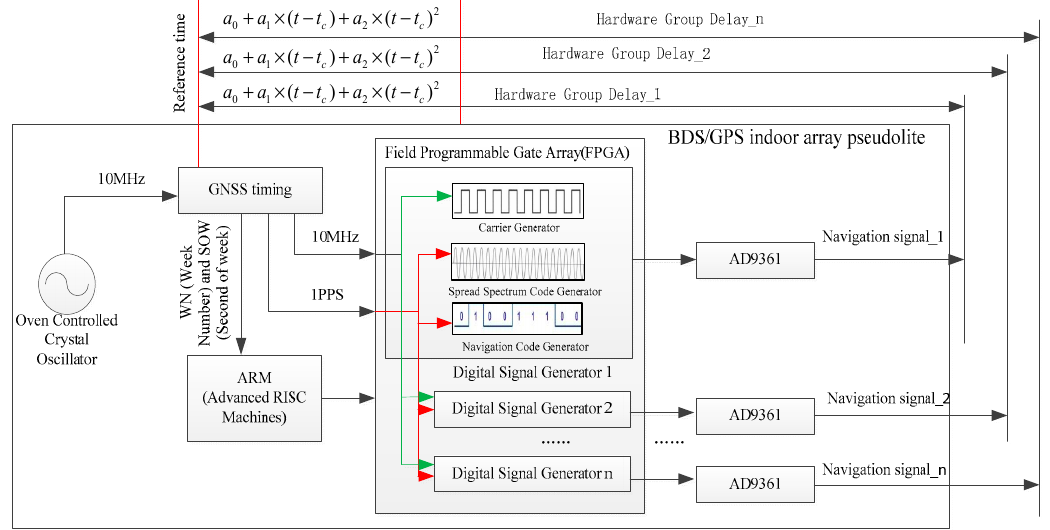
Figure 1. Composition of Beidou satellite navigation system (BDS)/GPS indoor array pseudolite system.